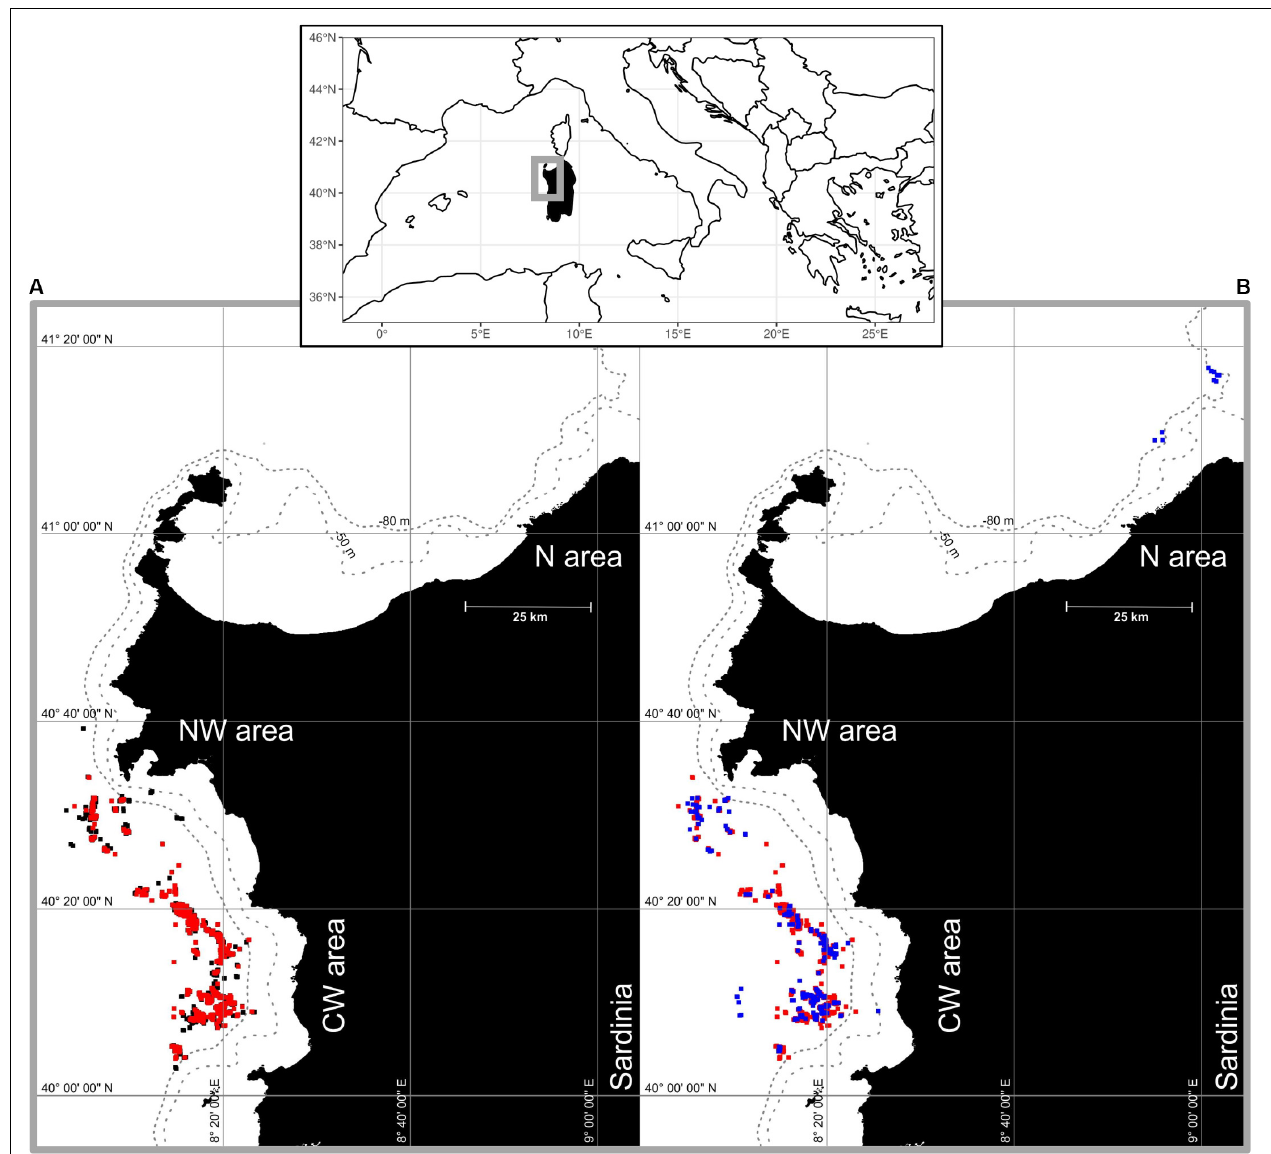
FIGURE 1 | ROV prospection (A) : black squares represent the sites where ROV failed to detect red coral banks, while red squares correspond to the record of Corallium rubrum colonies (i.e., coral points). Harvesting activities (B) : blue squares represent the harvesting sites and red squares the coral points. The bar corresponds to 25 km and the dashed gray lines to –50 and –80 m bathymetries, the minimum legal depth limits for collecting red corals in Sardinian waters in the investigated period (see main text and Supplementary Table S1 for